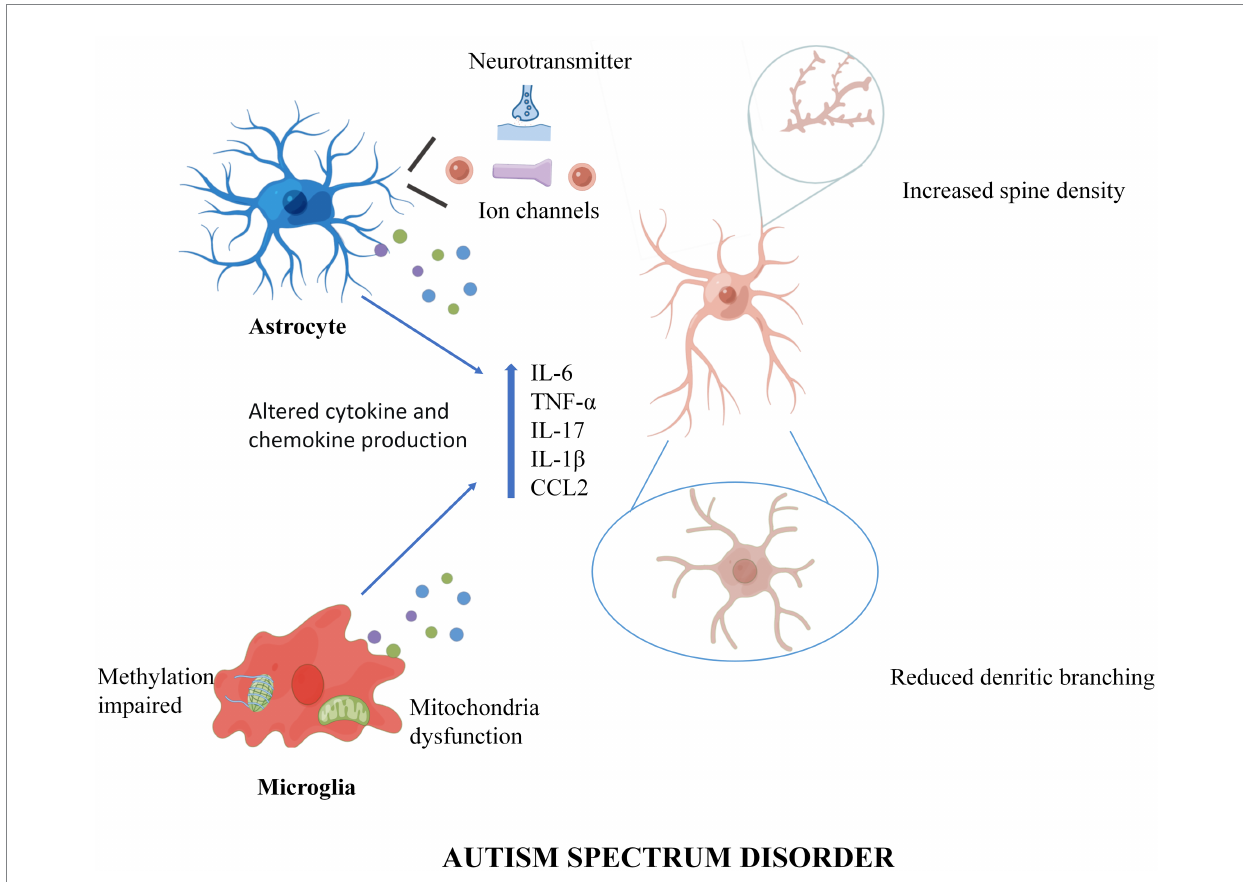
FIGURE 1 A working model of Microglia and Astrocytes underlie neuroinflammation and synaptic susceptibility in Autism Spectrum Disorder. In ASD, astrocytes enhance synaptic pruning through ion channels and neurotransmitters, while microglia trim synapses through intracellular methylation and mitochondrial alterations. In addition, both microglia and astrocytes can cause neuroinflammation and synaptic changes by releasing inflammatory cytokines and chemokines. Figures were created by Figdraw